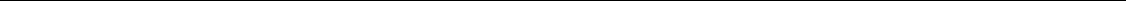
Figure 4 | SR-A suppresses M1/Th1 but induced M2/Th2 polarization. ( a ) Two weeks after adoptive transfer of infected mice derived peritoneal macrophages to normal WTmice, Th1 or Th2 cells in recipient mouse splenocytes were analysed. Data are expressed as the mean ± s.d. of 12 mice